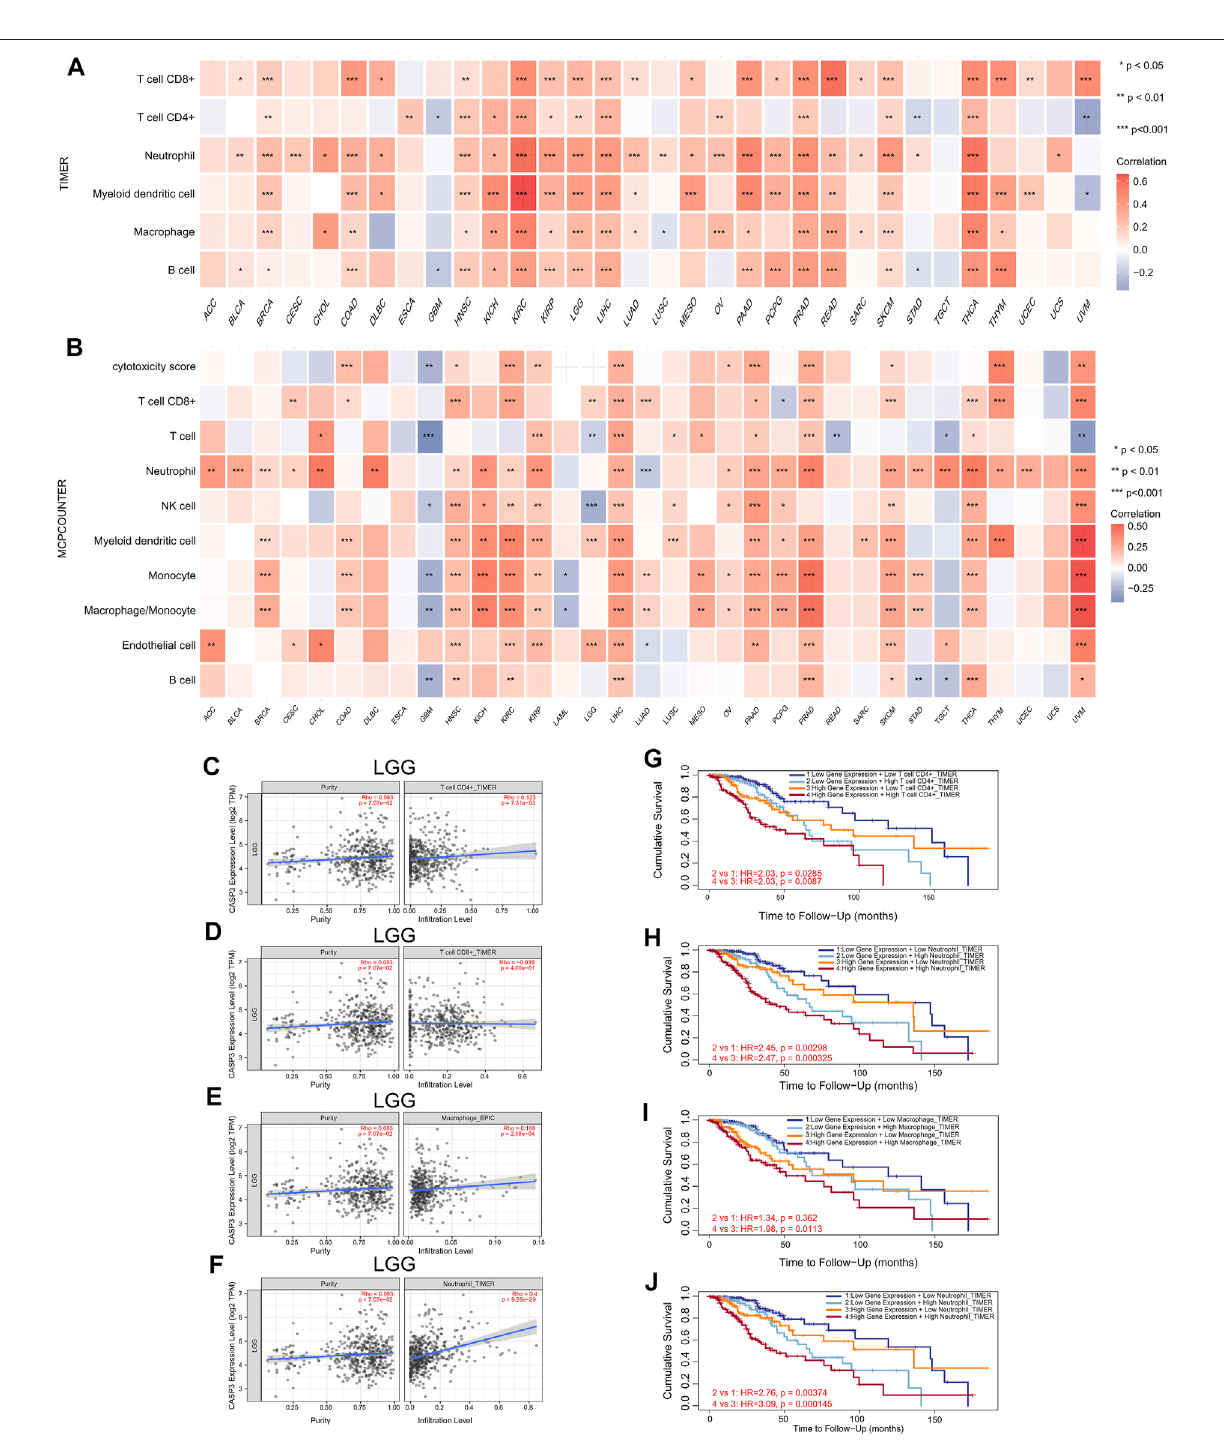
Frontiers in Molecular Biosciences |